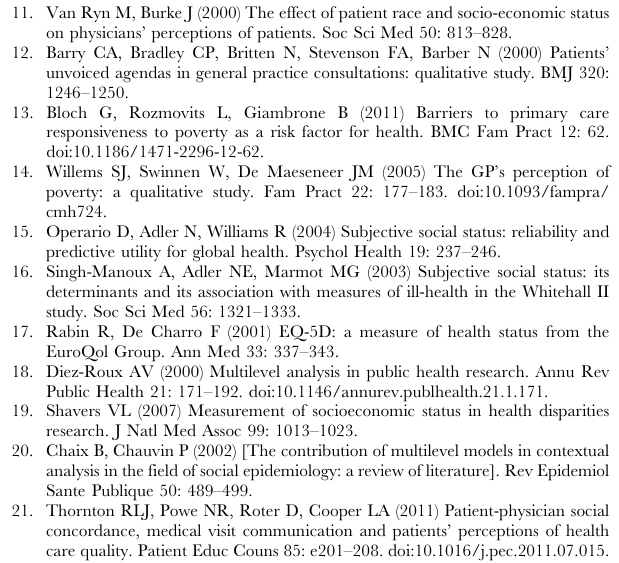
Table S1 Comparison between patients who have or have not answered about their household’s income amount, using chi-square and t-test. Table S2 Univariable analysis of GP evaluation of patient social status, with patient and doctor level